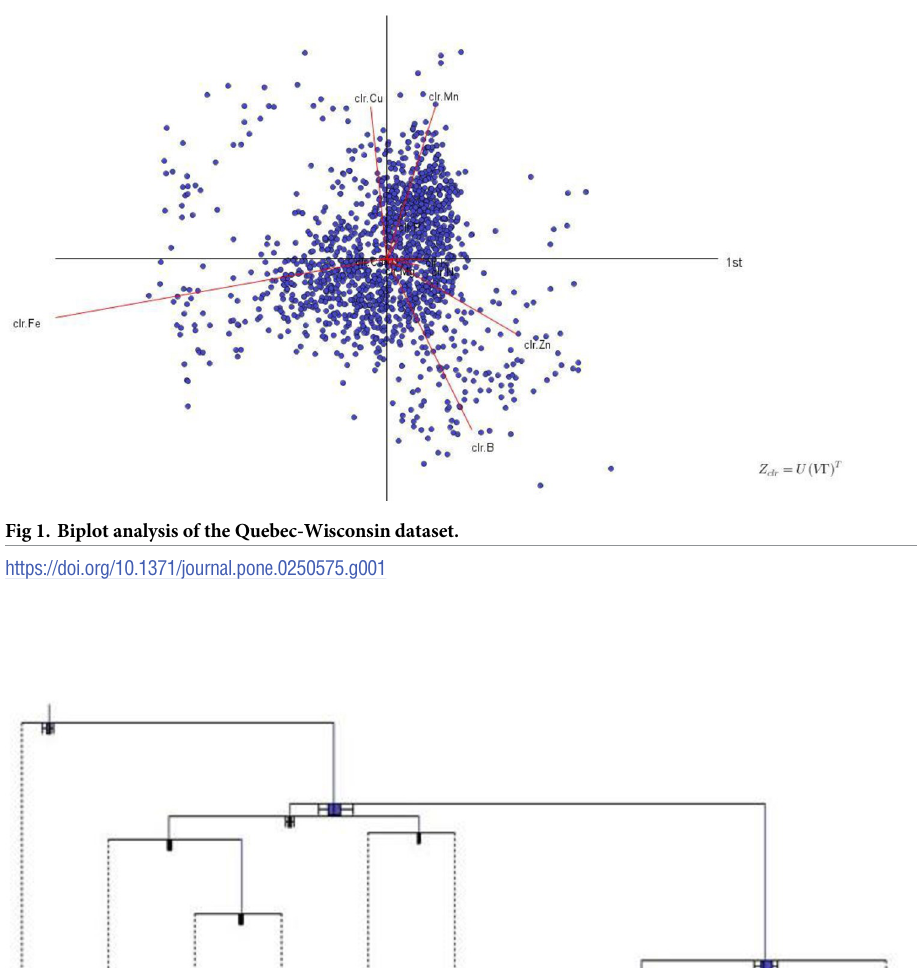
PLOS ONE | https://doi.org/10.1371/journal.pone.0250575 May 10,